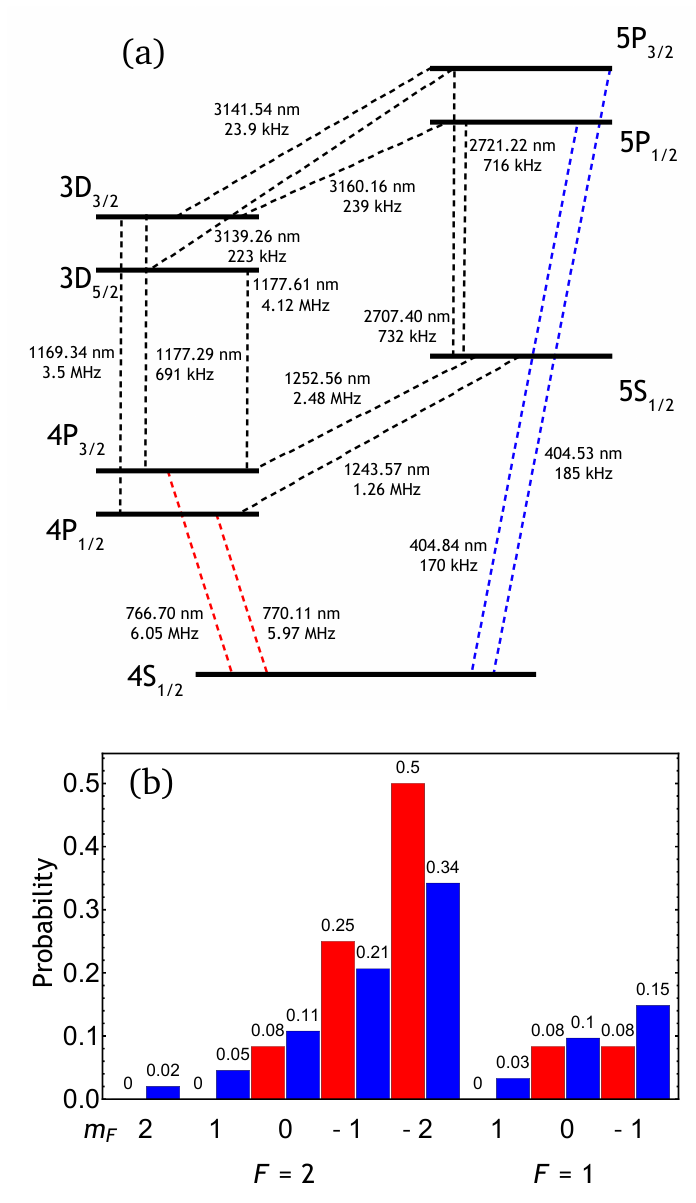
Figure 1: (a) Energy level diagram with all allowed transitions between the 4S and 5P levels. Corresponding wavelengths and individual linewidths Γ / 2 π are 3 / 2 also shown [ 40 ] . For states with multiple decay channels, the effective linewidth is given by the sum of the linewidths of each possible decay from that state. Dashed red lines indicate typical transitions used for laser cooling in 39 K and dashed blue lines indicate the two possible transitions close to 404 nm. into different Zeeman states in the hyperfine ground states F = 2 and F = 1 due to radiative cascade. The red bars indicate the probabilities for decay from the | F = 1, m = − 1 〉 (relevant for the dRSC scheme in Ref. [ 33 ] ) and the blue bars 4P F 1 / 2 | F = 1, m = − 1 〉 from the 5P F 1 / 2